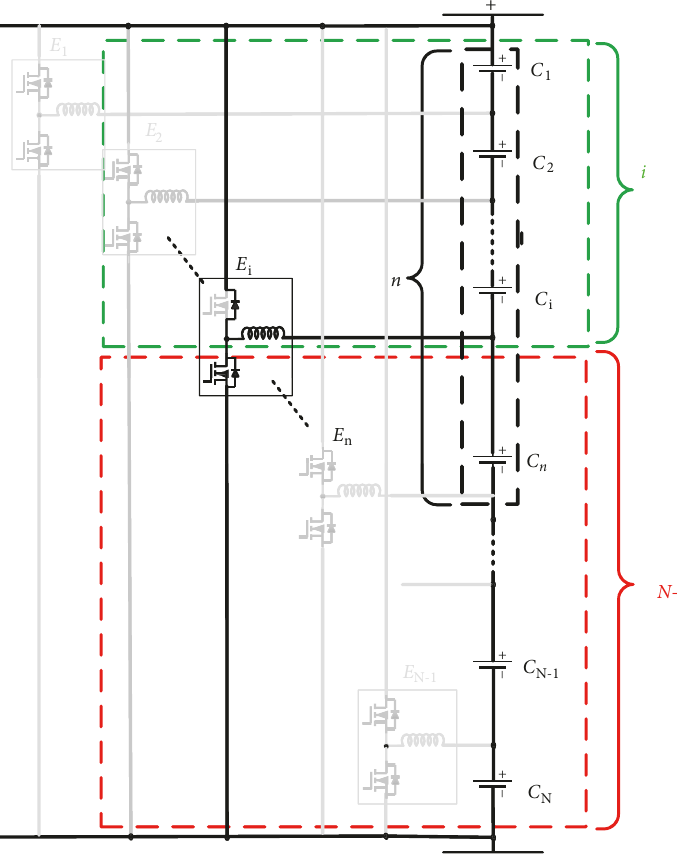
Figure 5: Energy transfer caused by the equalizer E i in situation